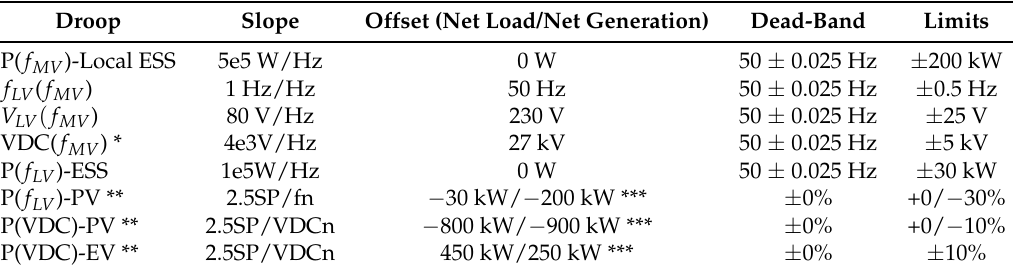
Table 4. Droop Controllers: main characteristics.